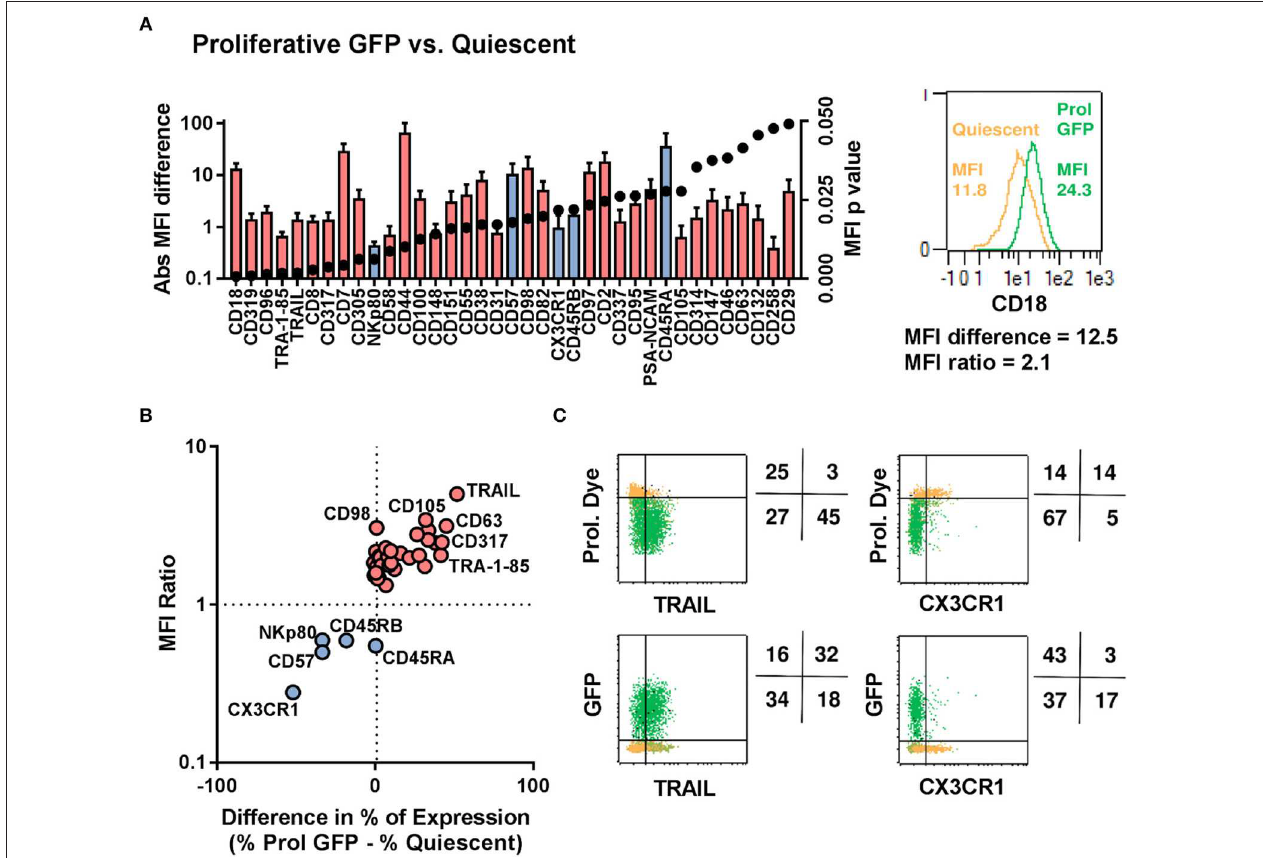
FIGURE 5 | Proliferative/LV-Transduced subsets of NK cells show distinct phenotype to that of quiescent/non-transduced subsets. NK cells from 5 donors were analyzed for 371 surface markers by flow cytometry. (A) Direct comparison of quiescent, proliferative and GFP positive NK cells. (B) Different cell surface marker was plotted based on their differential expression between transduced and non-transduced subset. (C) Proliferation and transduction of TRAIL + subset and CX3CR1 − subset of NK cells are shown.